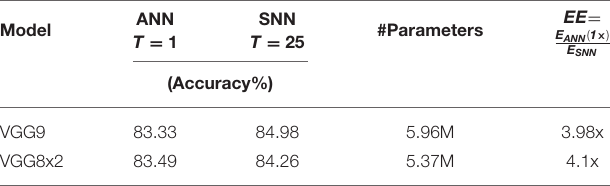
TABLE 14 | Accuracy, Total, # parameters, and Energy Efficiency EE for AGD trained SNN topologies (refer Table 15 ) with hybrid ReLU/LIF neurons of latency T = 25 and corresponding ANN on CIFAR10 data.